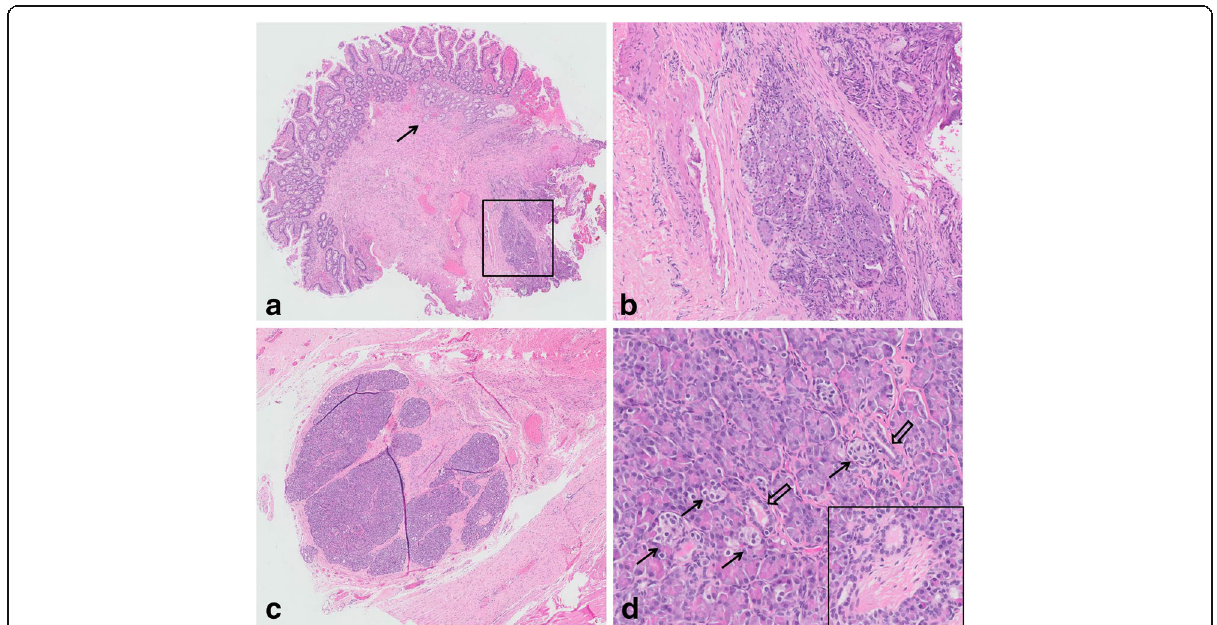
Fig. 4 Haematoxylin and Eosin (H&E) micrographs. The small bowel mucosa showed generally intact villous architecute, with Brunner ’ s glands observed in the laminia propria ( black arrow ). Smooth muscle bundles were haphazardly arranged in the underlying stroma, while no well- developed muscularis propria were seen ( a , original magnification ×20). At the cauterized edge, there were lobules of pancreatic tissue, comprising benign acini and islets of Langerhans ( b , ×100). A larger focus of pancreatic tissue was present in the fibrotic tissue ( c , ×20). All three components were observed, including acini, islets of Langerhans ( black arrow ) and ducts ( hollow arrow ) ( d , ×200). An intralobular nerve bundle was focally seen, adjacent to small ducts (inset, ×200)